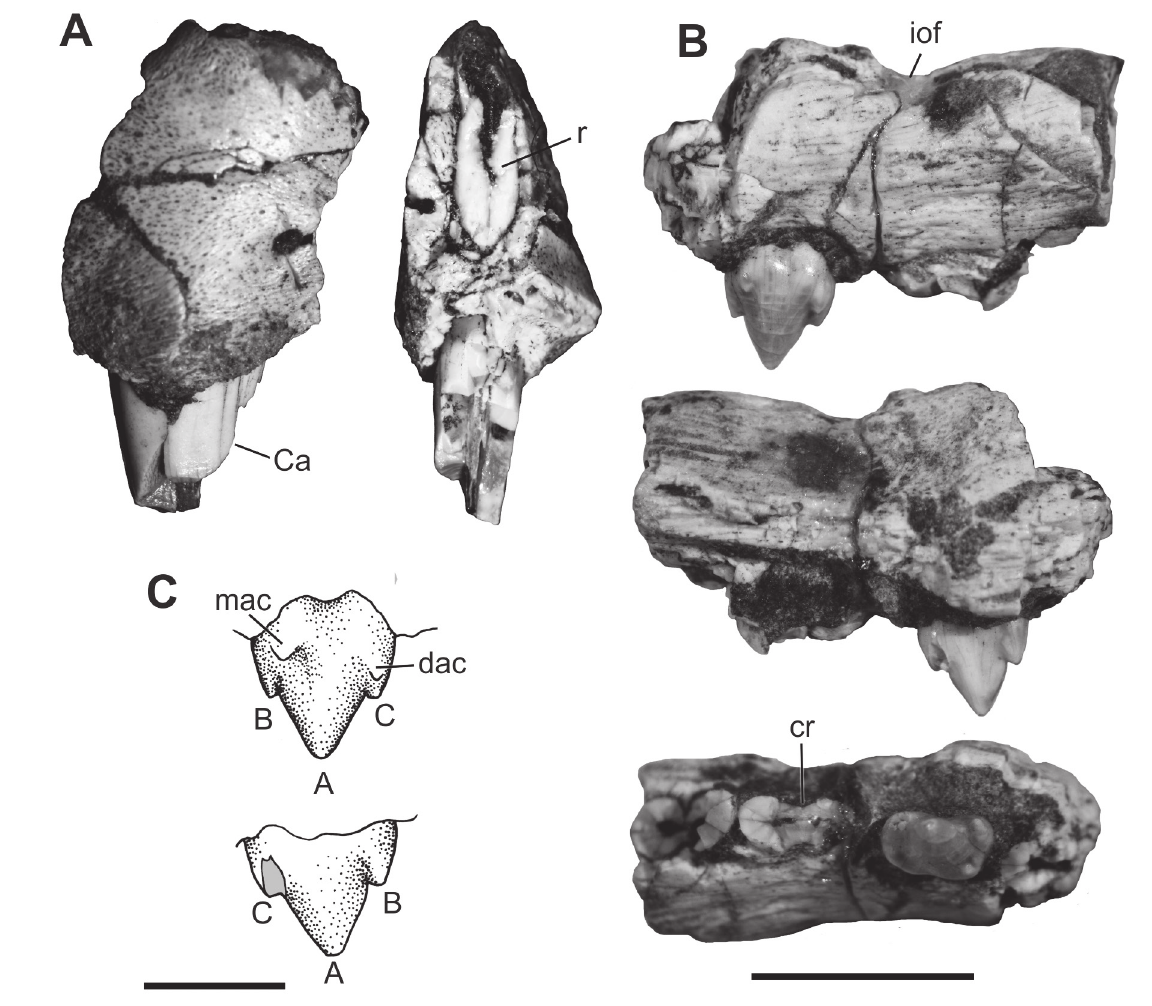
Fig. 3 - Holotype (MMACR-PV-003-T) of Botucaraitherium belarminoi gen. nov. et sp. nov. A: Fragment of left maxilla with portion of canine in lateral and posterior views . B: Fragment of left maxilla with postcanine in lateral, medial and ventral views. C: Detail of upper postcanine in labial (lateral) and lingual (medial) views. Scale bars equals 5 mm in A and B and 2 mm in C . Gray areas indicate broken surfaces. Abbreviations: A-C , refers to name of cusps; Ca , upper canine; cr , constricted root; dac , distal accessory cuspule; iof, ventral edge of the infraorbital foramen; mac , mesial accessory cuspule; r,